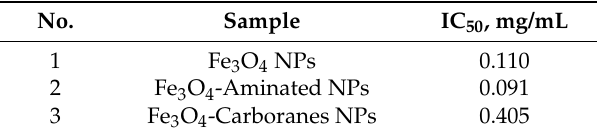
Figure 7. Cytotoxic effect of modified and non-modified Fe 3 O 4 NPs ( a ) on cultured mouse embryonic fibroblasts and its nonlinear curve fitting ( b ). Table 4. Inhibitory concentration (IC 50 ) for samples using MEFs.